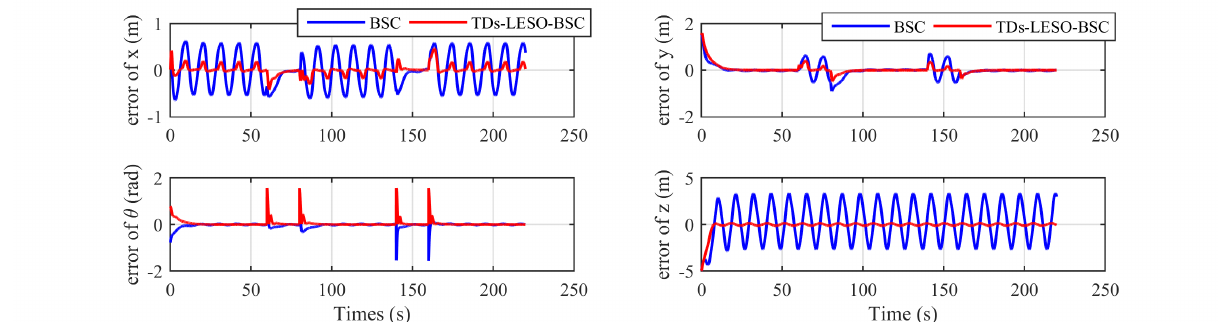
Figure 17. Thecomparisonofdifferentcontrollersfortrackingarasterscantrajectorywithseriousdisturbances.